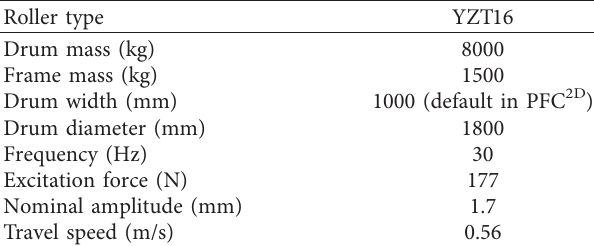
Table 5: Roller Parameters adopted in numerical simulation. Roller type